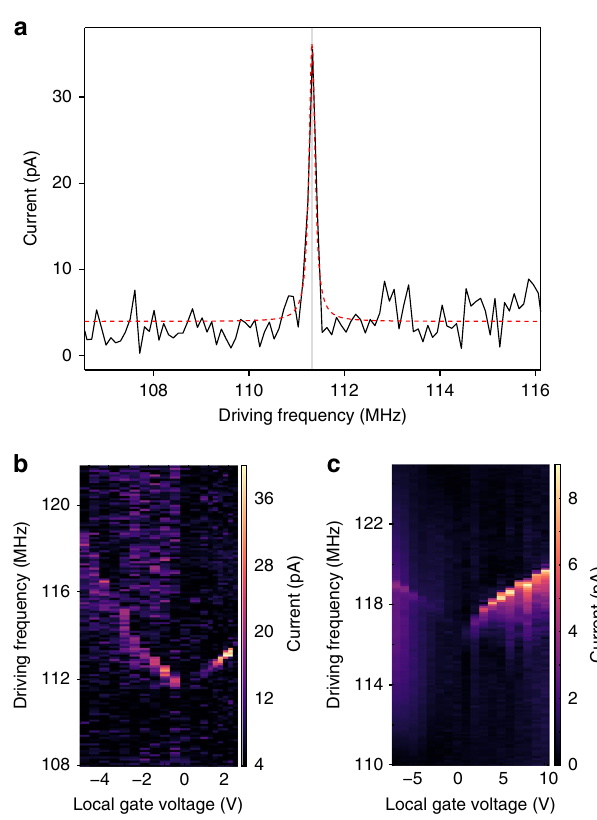
Fig. 2 Electromechanical characterization of MoS 2 NEMS resonators. a Frequency response of the mixing current for device R1, showing a characteristic peak around 111 MHz. The extracted quality factor is 225. The measurement is performed at V g = 1.5 V and input RF power = − 1 dBm. b , c The frequency response mapped as a function of local gate voltage and driving frequency for resonator R1 in b and R2 in c . The resonant frequency is highly tunable with gate voltage and shows different curvature, being concave for R1 and convex for R2. The faint background is due to the noise in mixing current. The input RF power is − 1 and 8.5 dBm for R1 and